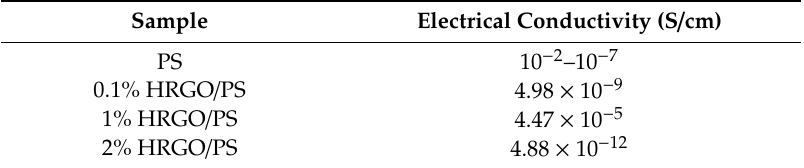
Figure 7. I–V characteristics of HRGO / PS nanocomposites containing ( a ) 0.1% HRGO / PS, ( b ) 1% HRGO / PS, and ( c ) 2% HRGO / PS. ( d ) Plot of electrical conductivity as a function of HRGO concentration in the HRGO / PS nanocomposites. Table 1. Summary of the electrical properties of PS and HRGO / PS nanocomposites.